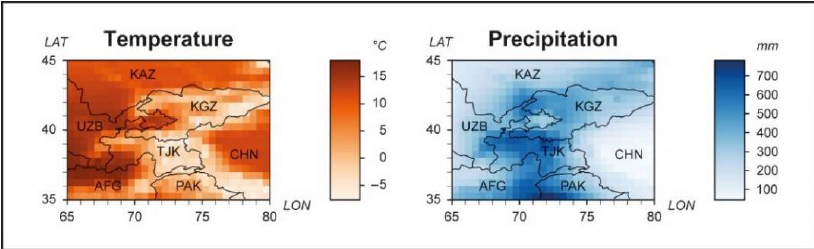
Figure 2. Mean annual temperature and precipitation sums within the study area for 1950–2016 using CRU TS 4.01.